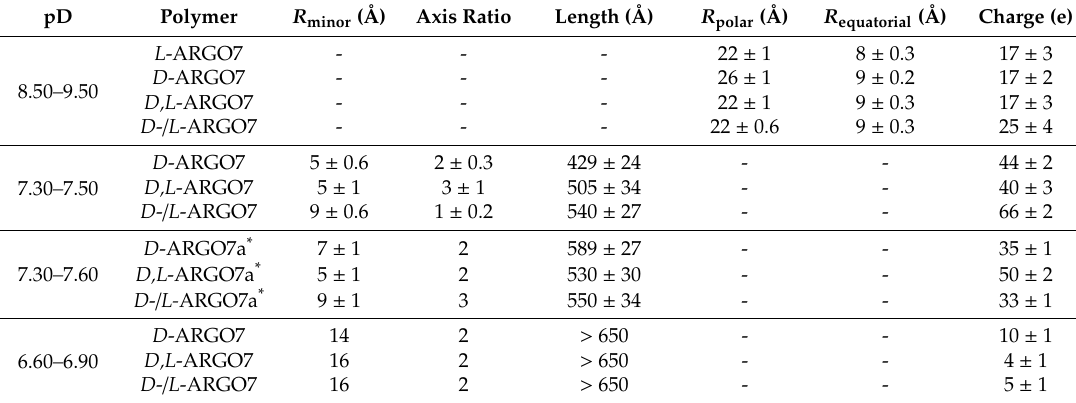
Table 2. Parameters obtained for 5 mg mL − 1 NaDC at various pD in presence of the polymers ( D -, L -, D,L -ARGO7 and the equimolar mixture D - / L -ARGO7) using either the hydrated ellipsoid or the hydrated elliptical cylinder mathematical model. Standard deviation is not indicated when < 1%. In all